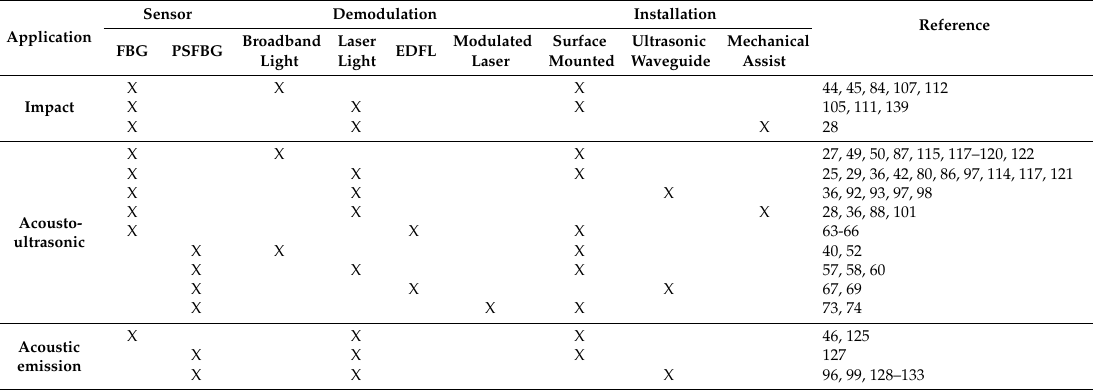
Figure 10. The comparison of three types of ultrasonic structural health monitoring techniques. Table 3. The summarization of FBG sensor, demodulation, and installation in three different ultrasonic SHM